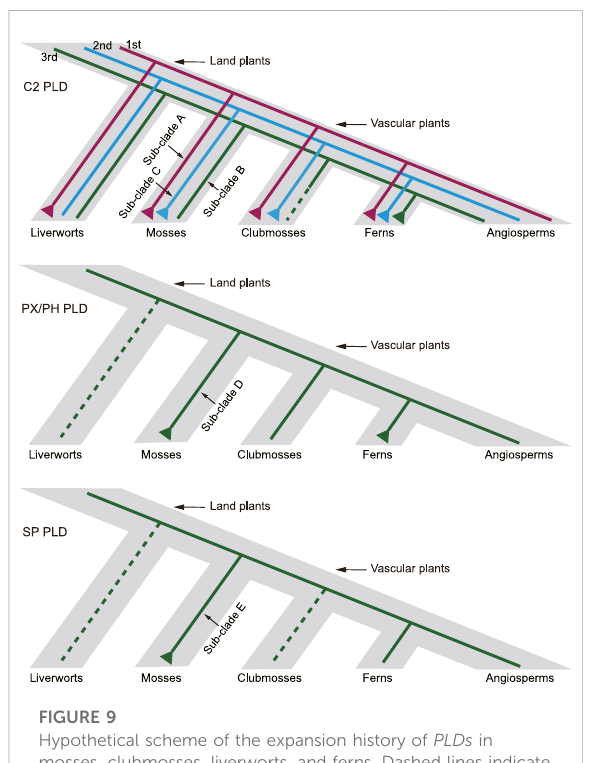
FIGURE 9 Hypothetical scheme of the expansion history of PLDs in mosses, clubmosses, liverworts, and ferns. Dashed lines indicate putative gene loss